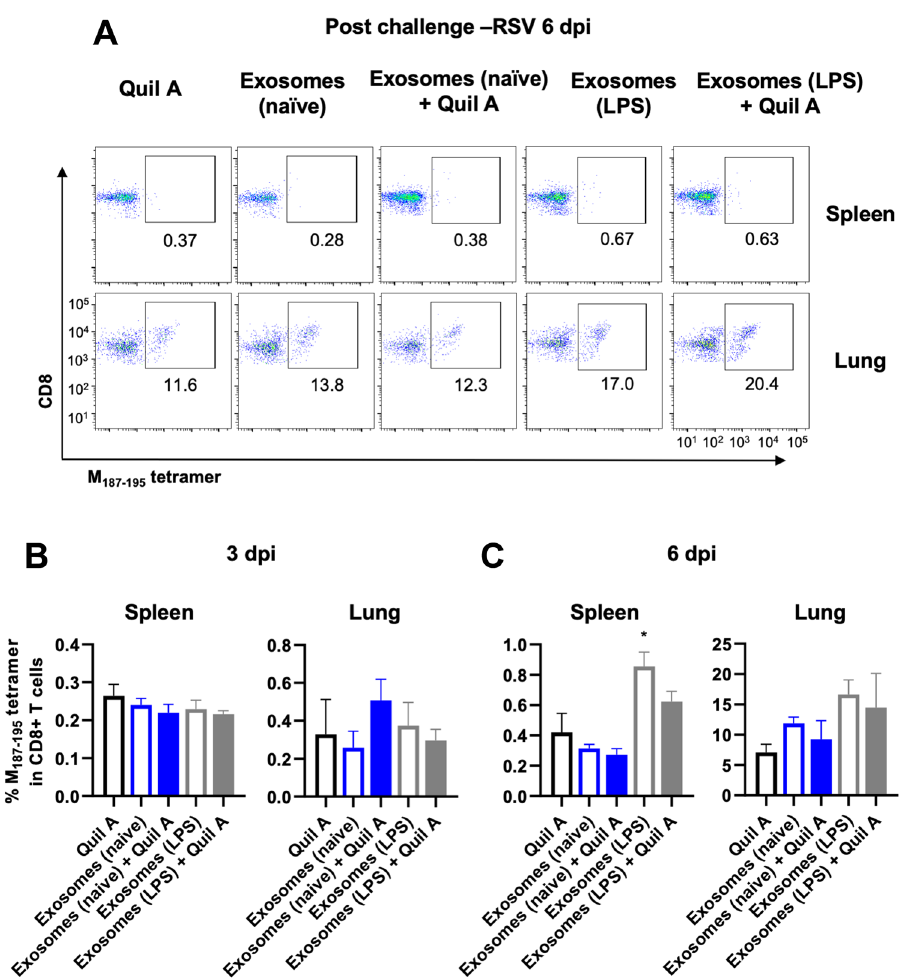
Figure 3. Confirmation of M 187–195 -specific CD8 T cells by tetramer staining. Groups of vaccinated mice were sacrificed either 3 or 6 days post-infection (dpi). Their lungs and spleens were stained with antibodies and analyzed by flow cytometry. ( A ) Representative flow cytometry plots of lungs and spleens at 6 dpi of RSV. ( B , C ) The antigen-specific CD8 T cells were determined based on M 187–195 -tetramer staining. Data are presented as means ± SEM. *p < 0.05 as determined by one-way ANOVA and Holm-Šídák’s multiple comparisons